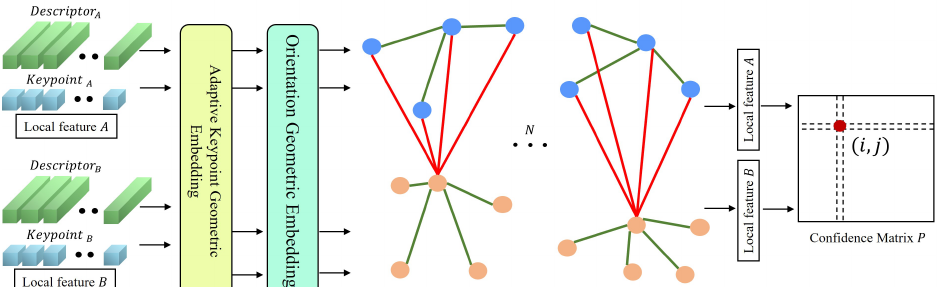
Figure 2. Overview of the proposed method. Our proposed method has four main steps. 1. The offset map is calculated by the local features. Keypoints are adaptively adjusted according to the offset map. 2. The main orientation is obtained with the offset map, and encoded as geometric information with sine-cosine encode values. The responses of local features and geometric information are embedded in high-dimensional features. Then, they are fused with descriptors. 3. The descriptors are processed by the Transformer module and the descriptors with contextual information are obtained. The Transformer module has L self-attention layers and cross-attention layers. 4. The matching score is calculated by the similarity of descriptors, and then dual-softmax is used to calculate the corresponding relationship between local features.